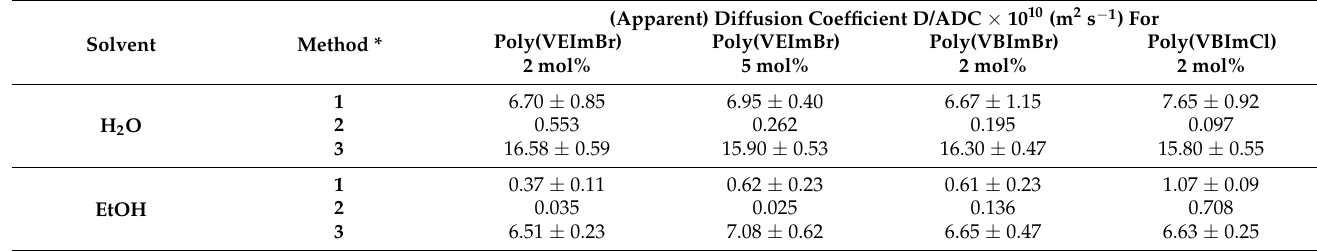
Table 6. Summary of all diffusion coefficients measured using different methods.